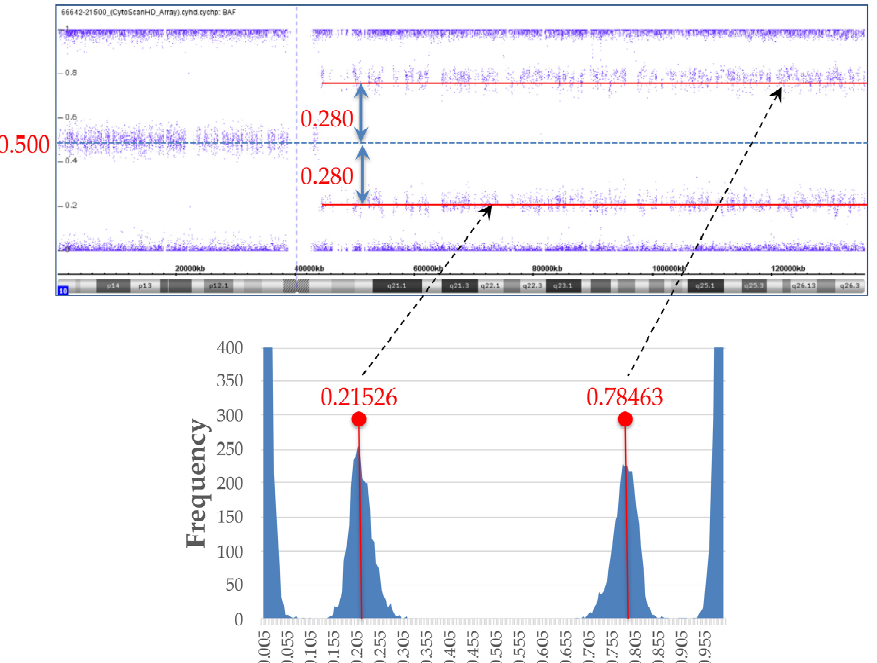
Figure 2. B-allele frequency (BAF) data and histogram from BAF data. For investigation of mosaic ratio, histogram was created from BAF data of single-nucleotide polymorphism (SNP) microarray (lower graph). Medians of two peaks in histogram were calculated, with BAF values of 0.21526, and 0.78463, respectively. Difference between peak median BAF value and BAF value of heterozygous SNPs of 0.5 was ±